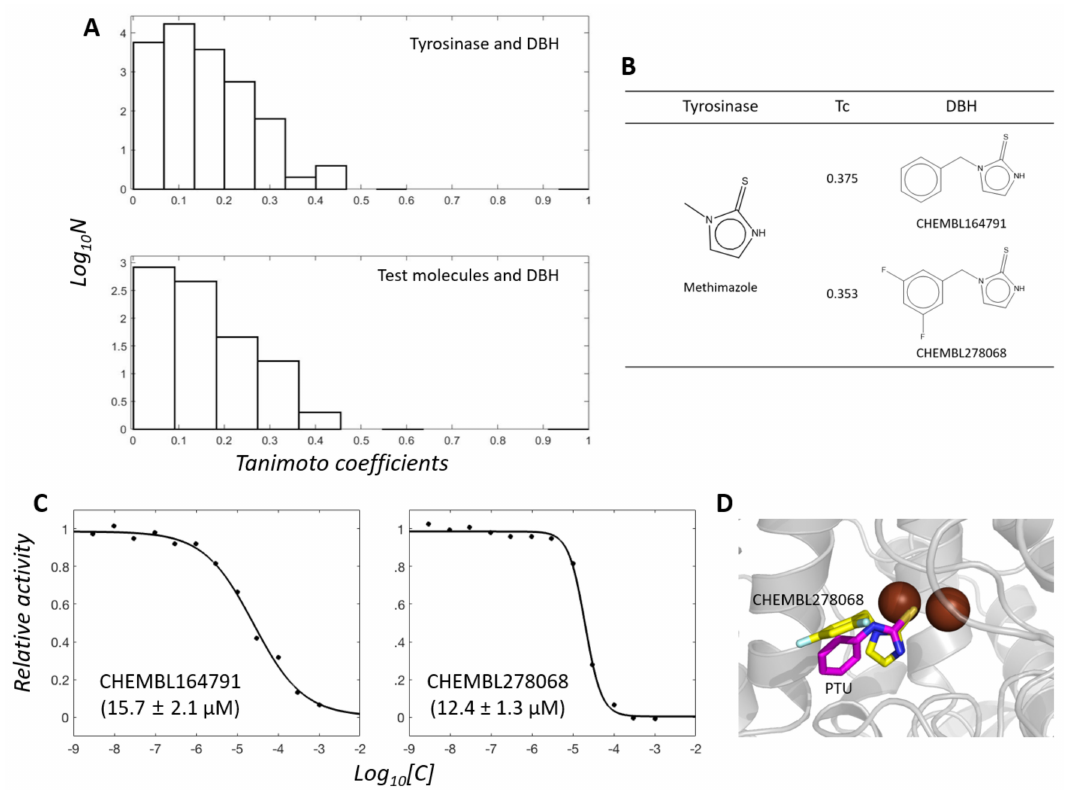
Figure 6. ( A ) Distribution of Tanimoto coefficients in the chemical pair from tyrosinase and DBH inhibitors. ( B ) Chemical similarity between methimazole and CHEMBL164791 and CHEMBL278068. ( C ) Inhibition profiles for tyrosinase by CHEMBL164791 and CHEMBL278068. Activities were scaled with relative values in the range of 0 to 1. Values in parentheses indicate K i values. ( D ) Docked pose of CHEMBL278068 (yellow) to tyrosinase. DOCK3.7 guided the docking of CHEMBL278068 into the mushroom tyrosinase coordinate (PDB code: 2Y9X). Brown spheres indicate copper atoms. The PTU structure (magenta) complexed with catechol oxidase [38] is overlaid for